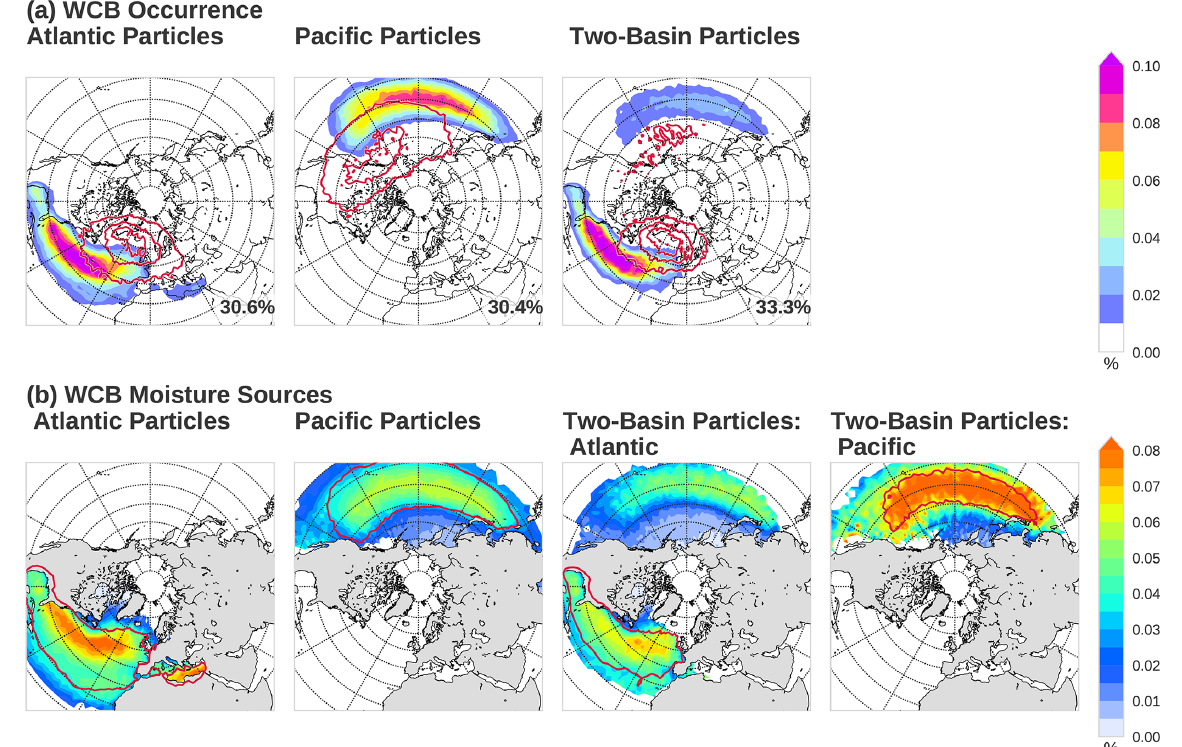
Figure 11. (a) Number density of the 20d tracked WCB particles released from Euro-Atlantic blocks at the starting time of the ascent (colour shading) and its ending time of their ascent (red contours) for each 2 ◦ × 2 ◦ grid cell for the Atlantic particles (left), Pacific particles (middle), and two-basin particles (right). The number at the bottom right of each panel indicates the fraction (%) of the particles of each category identified as WCB particles. (b) Moisture sources for WCB particles released from Euro-Atlantic blocks (colour shading) for the Atlantic particles (first column), Pacific particles (second column), and two-basin particles. The two-basin particles are separated into two figures, depending on the WCB locations of interest: for the WCBs over the Atlantic basin (third column) and the Pacific basin (last column). The red contours in each panel delimit 0.01% of the WCB starting locations. The percentage indicates the mean moisture contribution for the WCB ascent of each 2 ◦ × 2 ◦ grid cell, and they amount to 100% when they are summed up. Parallels are plotted for every 10 ◦ , whereas meridians are plotted for every 30 ◦ on each